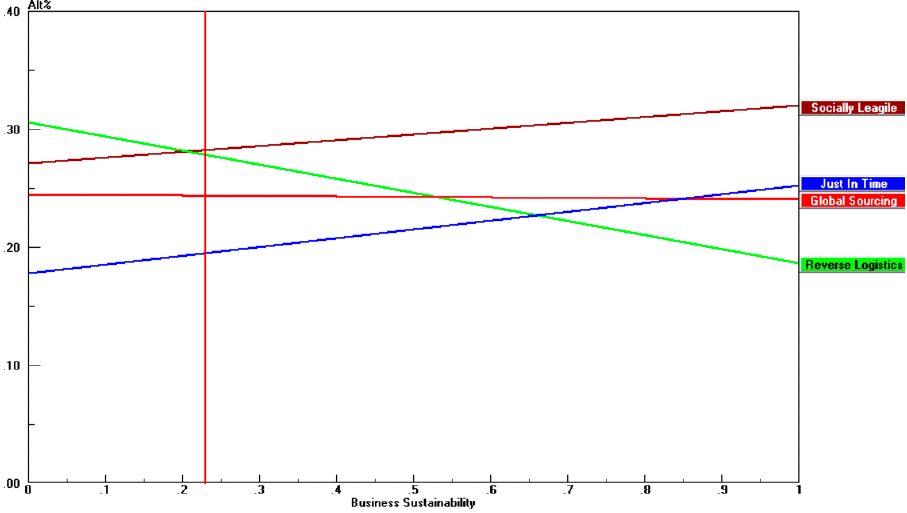
Figure 11. Sensitivity analysis of alternatives w.r.t. Business sustainability weight.